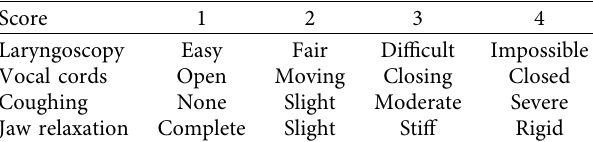
Table 1: Intubating condition